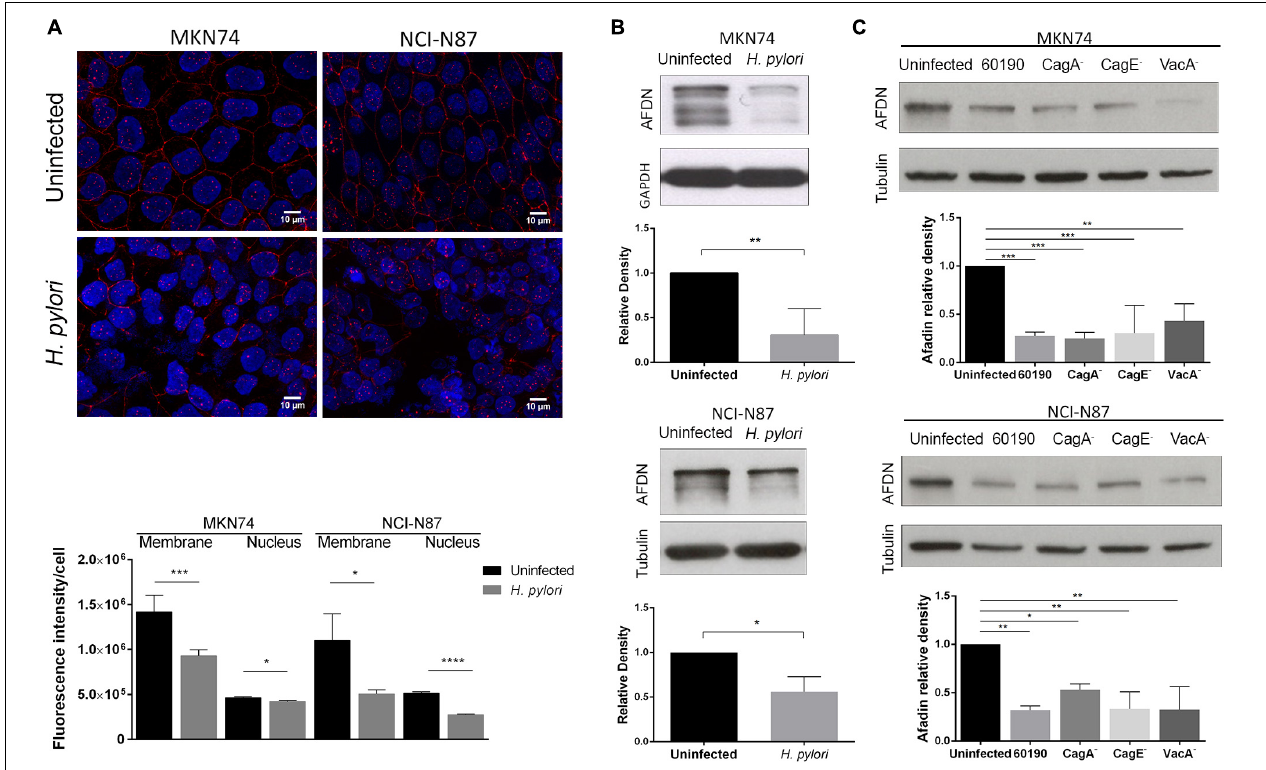
FIGURE 1 | Impact of H. pylori infection on Afadin expression. MKN74 and NCI-N87 gastric cell lines were left untreated or infected with H. pylori 26695 (A,B) or infected with H. pylori 60190, or with the respective CagA - , CagE - and VacA - mutants (C) , for 24 h at a MOI of 100. Afadin detection by immunofluorescence (red) and quantification of the fluorescence intensity at the membrane and the nucleus (A) , and by Western blot and its quantification, using GAPDH or tubulin as loading controls (B,C) . Scale bar, 10 µ m. Data correspond to the mean value ± SEM and are representative of at least three independent experiments. Statistical significance was evaluated with the Student’s t- test or with one-way